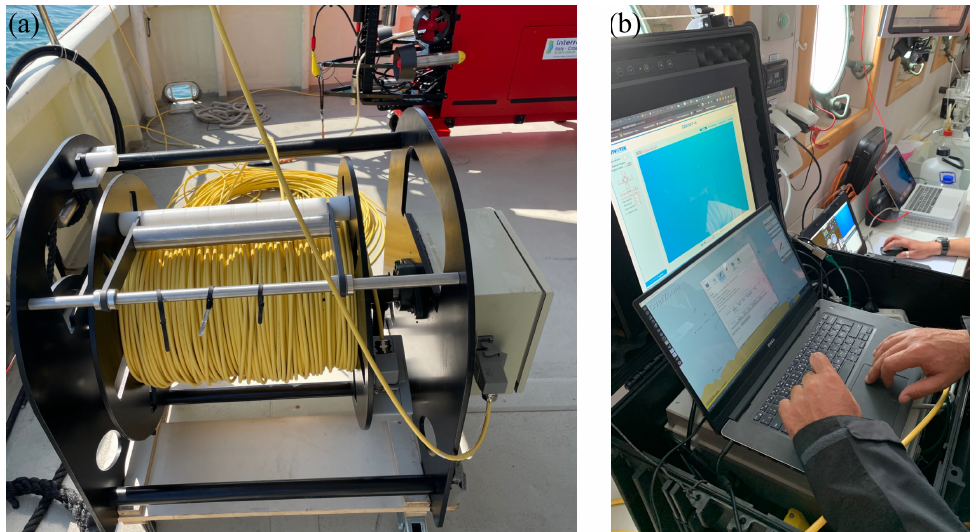
Figure 4. ROV navigation mode: ( a ) 600 m long fiber optic cable. ( b ) Computers for RS on surface vessel. All UUV subsystems and their functional connections are listed in Figure